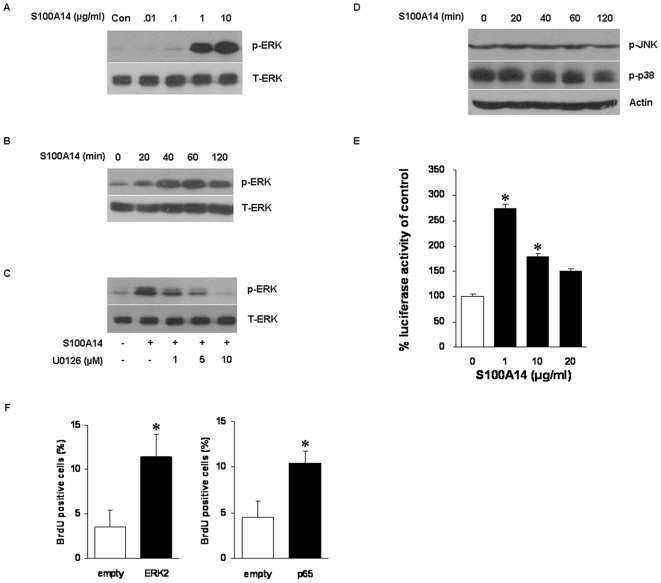
Low doses of S100A14 treatment activate ERK1/2 and NF-κB but not JNK or p38.(A) KYSE180 cells were incubated with different doses of S100A14 protein for 30 min, Myo117 was used as a control. (B) 10 µg/ml S100A14 added to KYSE180 cells for the indicated time periods. (C) Cells were pretreated with the MEK/ERK inhibitor U0126 for 30 min, followed by 10 µg/ml S100A14 exposure for another 30 min. T-ERK was used as a loading control. (D) No increased activity of the MAP kinase JNK or p38 was observed. Actin was used as a loading control. (E) Influence of S100A14 on NF-κB activity in KYSE180 cells was examined by luciferase reporter assay. Cells were treated with the indicated doses of S100A14 for 8 h and subjected to analysis of NF-κB activity (*, P<0.05). (F) KYSE180 cells transfected with ERK2 or NF-κB p65 plasmid were cultured for 24 h in the presence of 10 µM BrdU. Empty vector was transfected as a negative control. The percentage of BrdU-positive cells over the total number of cells was determined (*, P<0.05). Bars represent mean ± SD of three independent experiments.